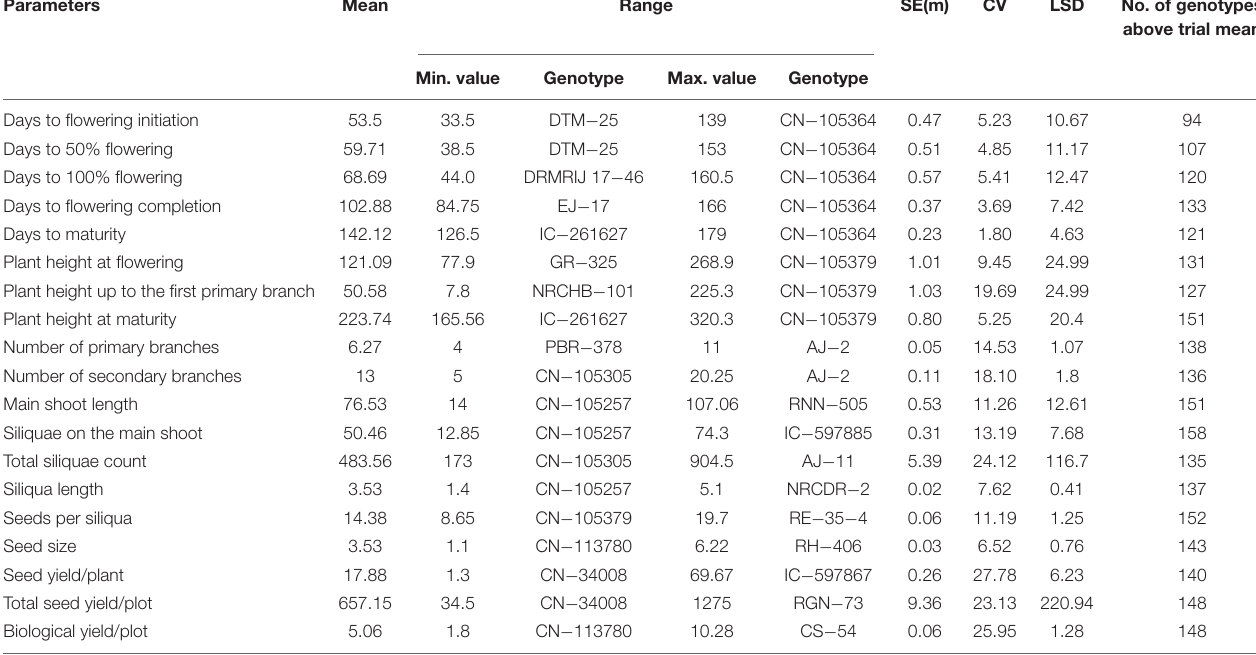
above trial mean